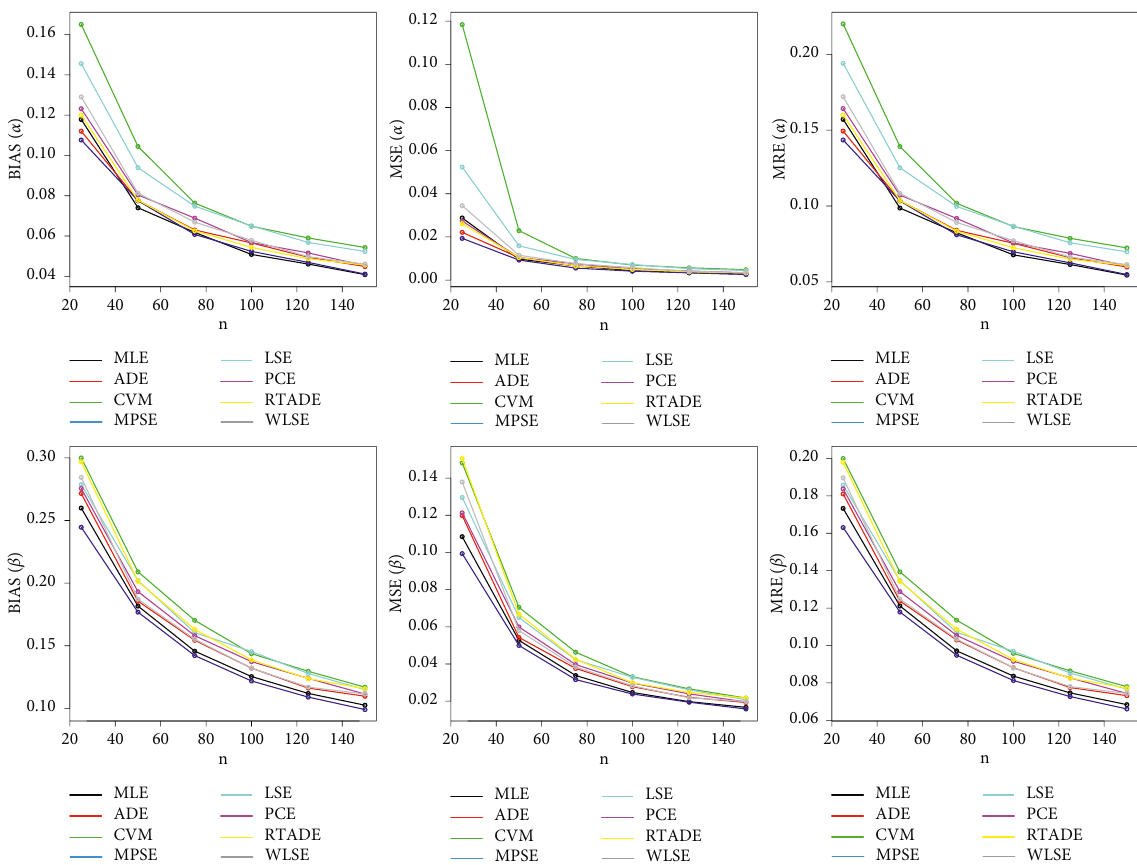
Figure 4: Graphical representation of BIAS, MSE, and MRE values in Table